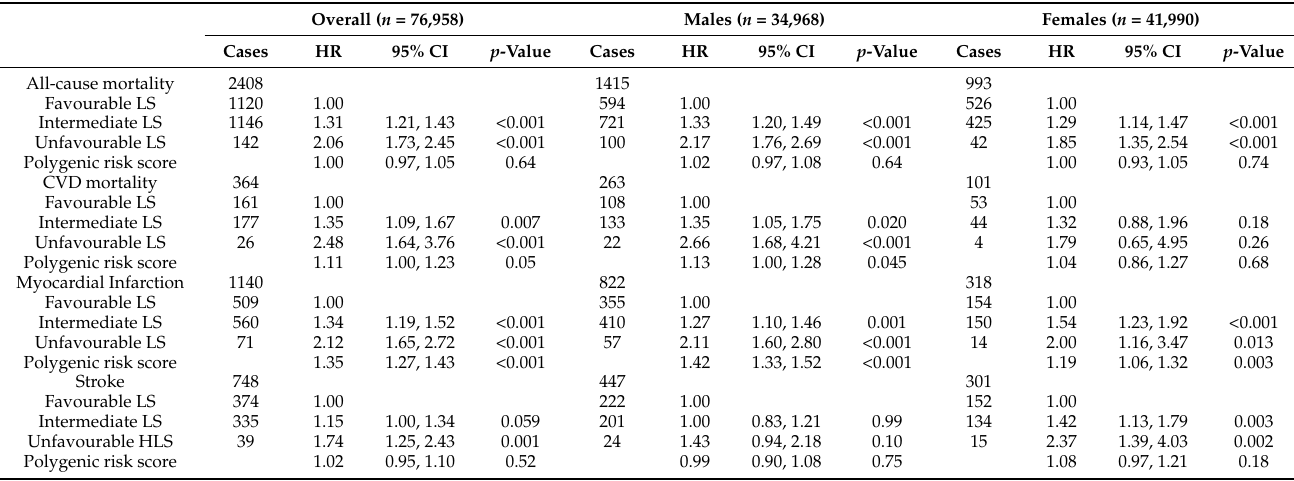
Table 2. Cox-proportional hazard models for CVD and all-cause mortality and CVD events according to a favourable, intermediate or unfavourable Lifestyle Score (LS) and polygenic risk score in UK Biobank